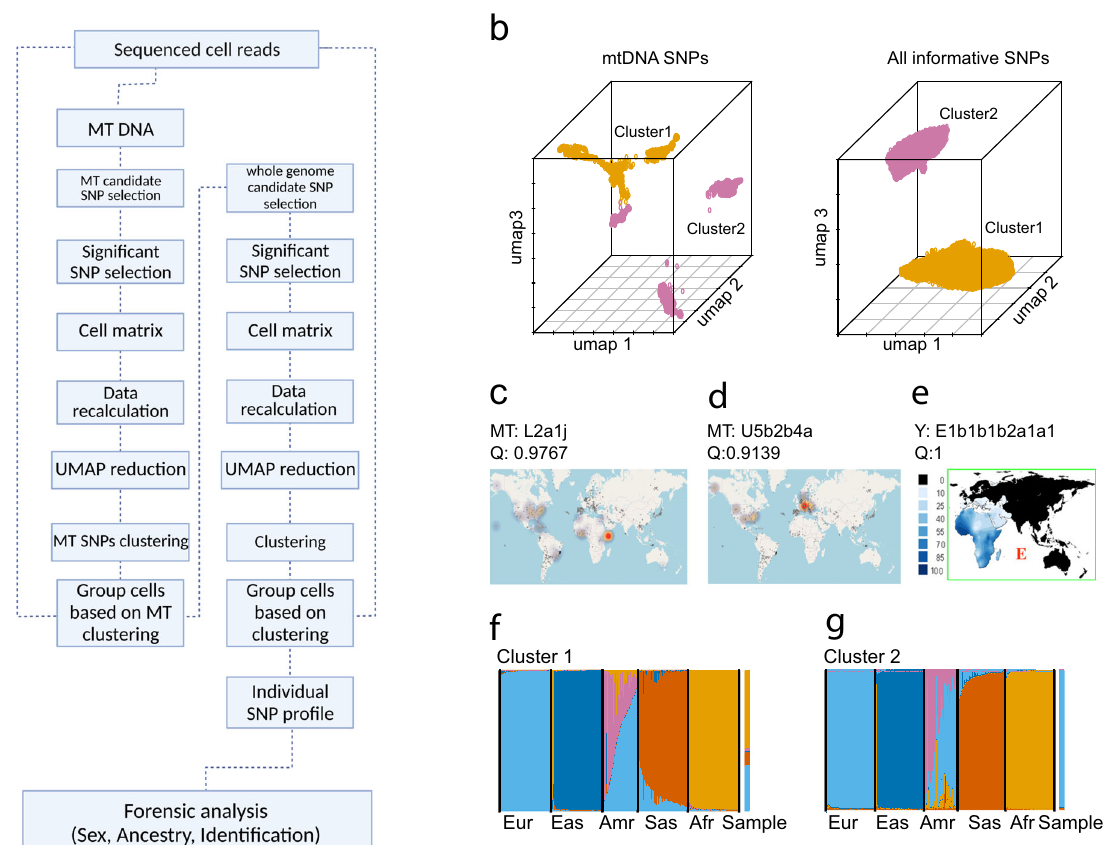
Fig. 1 De-goulash bioinformatics pipeline for genetically deconvoluting a multi-person biological mixture with subsequent genetic characterization and individual identi fi cation of the separated mixture contributors based on single-cell transcriptome sequencing data. Pipeline description and application on balanced two-person blood mixture. a The de-goulash pipeline work fl ow for single-cell-based mixture deconvolution with pre-processing of the scRNA-seq sequencing data in two iteration steps (mtDNA SNP-based separation followed by genome-wide SNP-based separation). b The 3D UMAP representation of the two-step single-cell separation process of a balanced two-person blood mixture (dataset M2) involving one male contributor of East African ancestry and the one female contributor of European ancestry. c EMPOP 47 map of the worldwide distribution of mtDNA haplogroup L2a1j inferred from haplogroup-diagnostic mtDNA SNPs of cell cluster 1 with inferred African maternal ancestry. d EMPOP map of mtDNA haplogroup U5b2b4a inferred from haplogroup-diagnostic mtDNA SNPs of cluster 2 with inferred European maternal ancestry. e Literature map 53 of Y haplogroup E inferred from haplogroup-diagnostic Y-SNPs of cell cluster 1 with inferred African paternal ancestry. Cluster 2 did not present a Y haplogroup due to female sex, as also revealed in the genetic sex analysis for cluster 2, while for cluster 1 male sex was obtained. f , g Biparental ancestry analysis with STRUCTURE of the genome-wide SNPs obtained per each of the cell clusters with continental reference population data (Eur: Europeans, Eas: East Asians, Amr: Native Americans, Afr: Sub-Saharan-Africans), the result for the cells clusters are denoted as Sample, result for cell cluster 1 demonstrates inferred admixed biparental ancestry with a major African ancestry, result for cell cluster 2 demonstrates European biparental ancestry. The maternal, paternal, and bi- parental genetic ancestries inferred from cell cluster 1 and 2 agree with the family-based ancestries of the two individuals involved in the